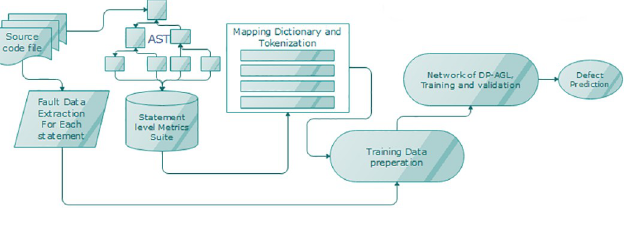
Fig 1. The high-level overview of the DP-AGL architecture.